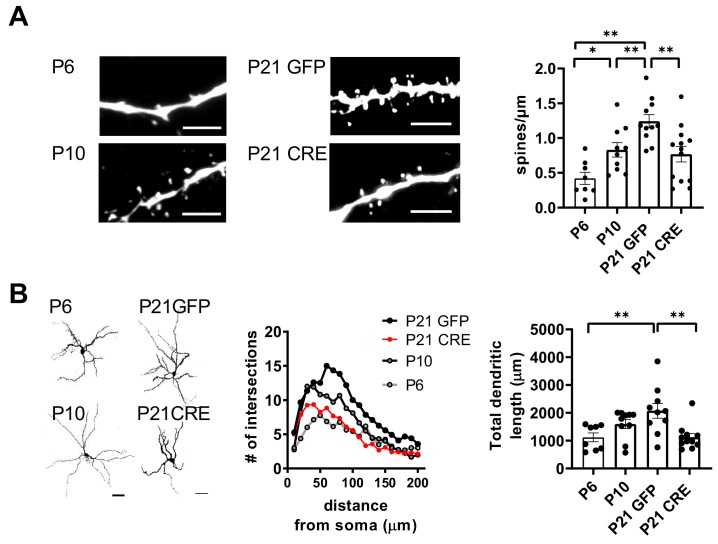
Development of CeA neuron morphology in control mice and in cKO mice lacking GluK1 in the BLA.(A) Morphological characterization of biocytin filled CeA neurons from WT mice (P6 and P10) and P21 Grik1 cKO mice, injected with GFP-CRE or GFP (control) encoding AAV viruses to the BLA at P2-4. Example images and pooled data [P6 n = 8 (3); P10 n = 10(3); P21 GFP n = 11(4); P21 GFP-CRE n = 13(4)] illustrate developmental increase in spine density from P6 to P10 and from P10 to P21 in control mice (ANOVA F(3,38)=9.59, p<0.001; Holm-Sidak post-hoc comparison, P6 vs P10 t = 2.567, p=0.014; P10 vs P21 GFP t = 2.803, p=0.008). Following GluK1 inactivation, the spine density at P21 remains similar to P10 WT (Holm-Sidak, P6 vs P21 CRE t = 2.298, p=0.027; P10 vs P21 CRE: t = 0.441, p=0.662). **p<0.01. Scale bar, 5 µm. The n number refers to the number of experiments, followed by the number of animals in brackets. (B) Sholl analysis of the same neurons. The number of dendritic intersections and the total dendritic length is significantly increased during development from P6 to P21 in control mice (two-way ANOVA for dendritic intersections, F(19,418)=2.89, p<0.0001). Following GluK1 inactivation, the mean dendritic length and branching at P21 remains similar to P6–P10 WT’s (dendritic length, ANOVA F(3,35) = 5,724, p=0.003; Holm-Sidak post-hoc comparison P6 vs P10, t = 1.702, p=0.098; P10 vs P21 GFP, t = 1.771, p=0.085; P6 vs P21GFP t = 3.371, p=0.002; P6 vs P21CRE, t = 0.011, p=0.991; P10 vs P21CRE t = 1.835, p=0.075. Dendritic intersections, P10 vs P21CRE, two-way ANOVA F(11,240)=0.728,p=0.71). Confocal images (z-stack) illustrating the morphology of the dendritic tree. **p<0.01. Scale bar, 50 µm.